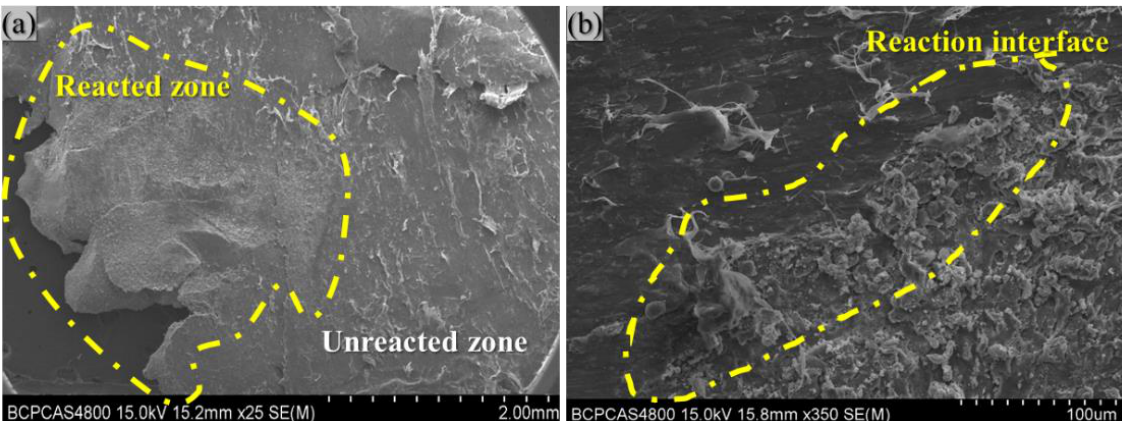
Figure 9. ( a ) Reacted specimen after drop-weight test; ( b ) reaction interface.